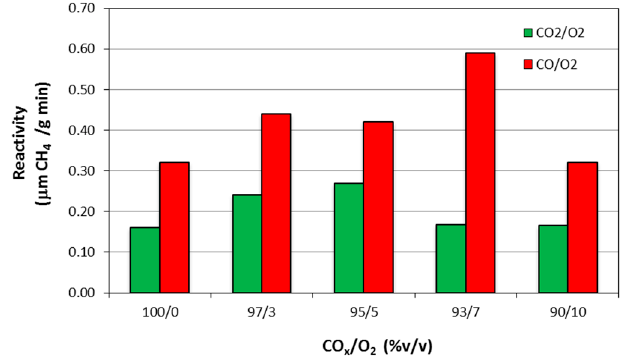
Figure 3. CH 4 production ( µ mol of methane by gram of catalyst/minute) as a function of CO 2 /O 2 and CO/O 2 ratios, over Rh(1%)/ γ‐ Al 2 O 3 catalyst, at 125 °C. Adapted from Beuls et al. [31].